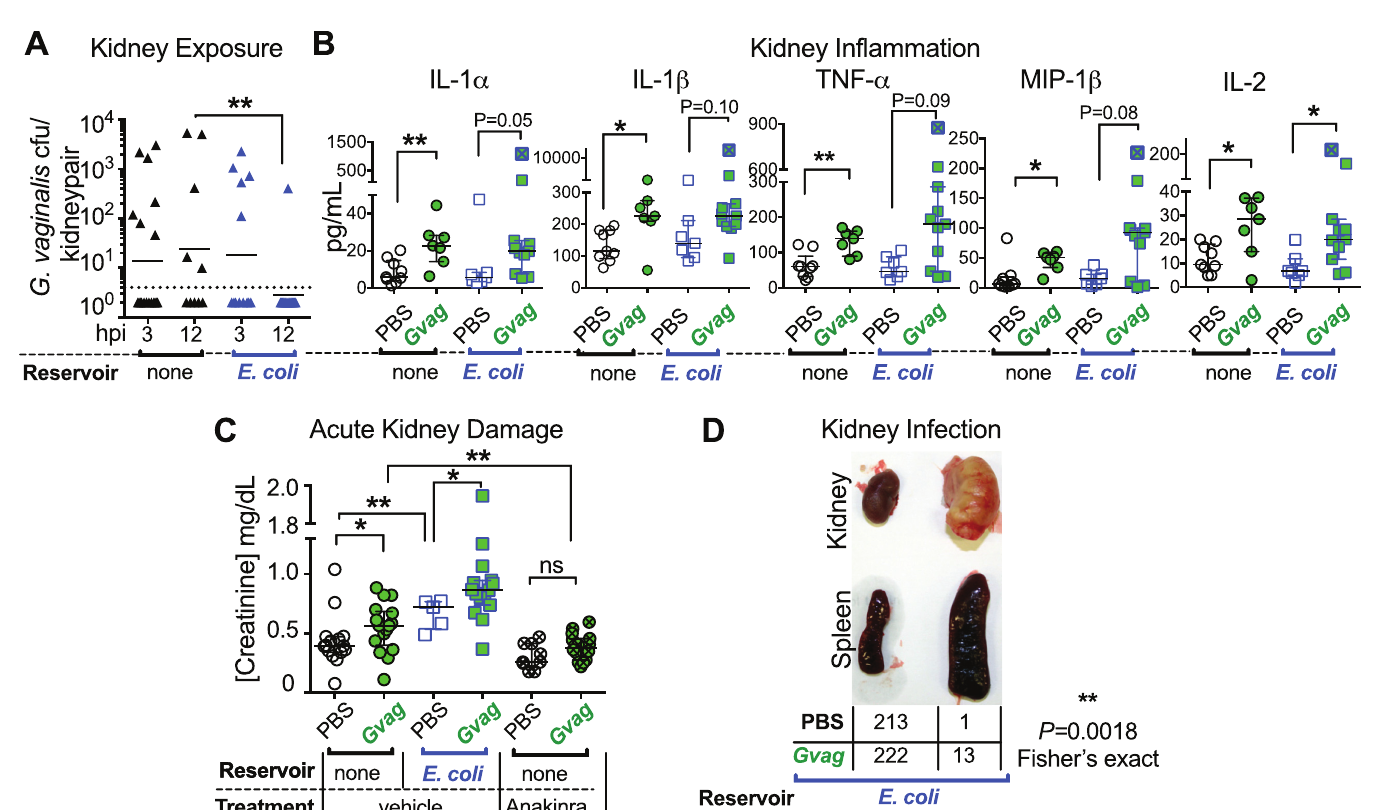
Fig 4. G . vaginalis causes IL-1 receptor-mediated kidney injury and increasesthe incidence of severe E . coli kidney and systemicinfection. ( A-C ) Data are from mice that were exposedtwice (12 h apart) to PBS or G . vaginalis as describedin S3 Fig. ( A ) G . vaginalis titers in kidney tissue. ( B ) Cytokine/ chemokinelevels in kidney homogenates at 12 h after the second exposure. Kruskal-Wallis tests were performed followedby post hoc pairwisecomparison. For comparison, data from an abscessed kidney collectedat 72 h after exposure(not includedin the statistical analysis)are denotedby symbols with a blue ‘X’. ** P < 0.005, * P < 0.05, Mann-Whitney (uncorrected P values). ( C ) Serum creatininelevels, a marker of acute kidney injury, at 12 h after the second bladderexposure. Mice received 2 intraperitoneal injections of PBS (vehicle) or anakinra at ~16h prior to and at the time of transurethral inoculation.N = 6 independentexperiments. ** P < 0.005, * P < 0.05. ( D ) Incidenceof E . coli kidney infectionwith abscessedkidney and splenomegaly at 72 h post exposure. Data are compiledfrom 12 experiments with two exposures (12 h and 1 wk apart, includingmice injectedwith PBS as in C) and 1 experiment with 3 exposures, each 24 h apart. ** P = 0.0018, Fisher’s